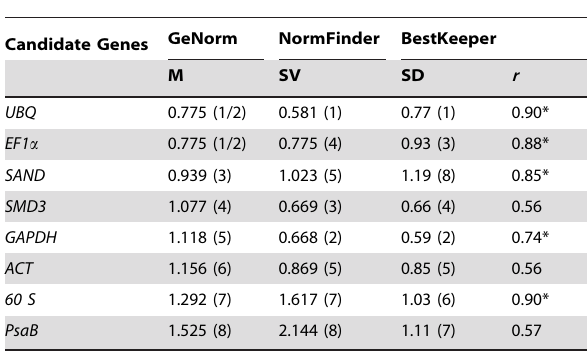
Table 2. Candidate reference genes for Biotic Stress effect in V. vinifera cv Trincadeira calculated by the GeNorm, NormFinder and BestKeeper.